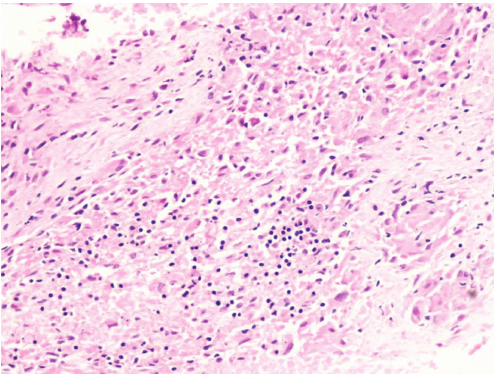
Figure 1: CT scan of the chest is showing a homogenous mass measuring 7.5cm × 6.0cm. The mass is compressing the trachea causing significant lumen compromise.